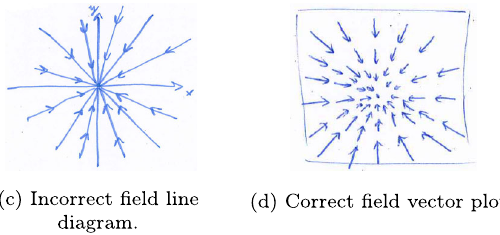
FIG. 12. Examples of student sketches in response to post-test question 5(c) (Fig.